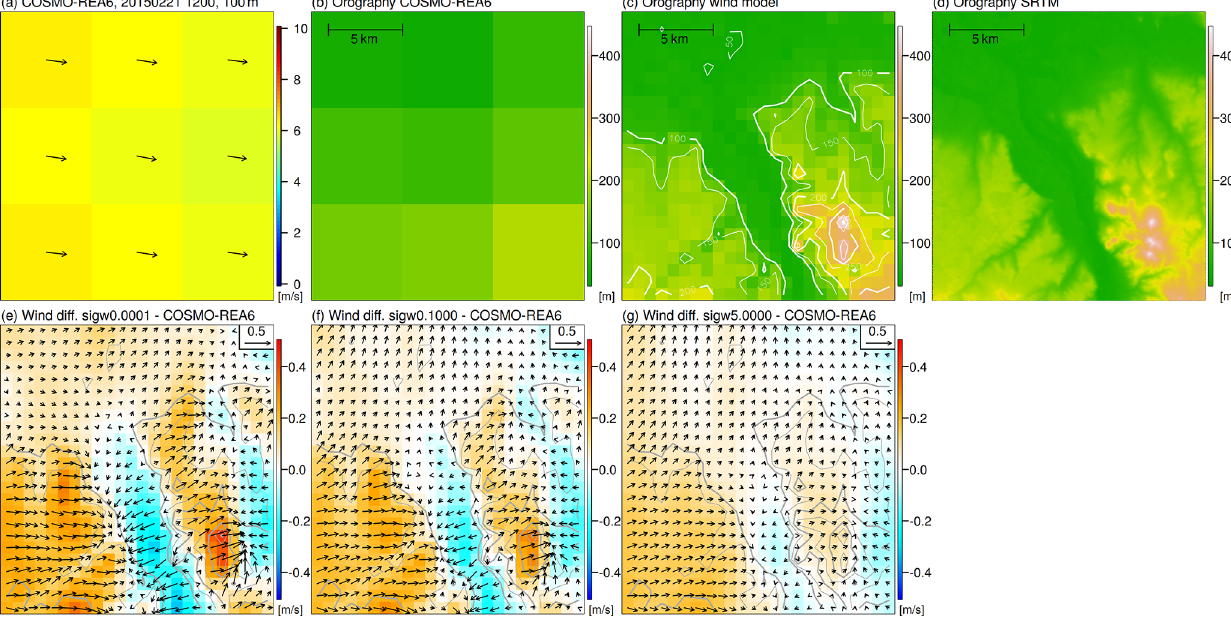
Figure 2. Snapshot of COSMO-REA6 wind speed (colors) and direction (arrows) on 21 February 2015 at 12:00UTC in western Germany (a) . Both wind components are vertically and horizontally interpolated from the native grid to 100m above surface and the grid box centers. Representation of the topography in COSMO-REA6 (b) , the diagnostic wind model (c) and in SRTM (d) . (e–g) Difference of the wind field from the diagnostic wind model with σ w values of 0 . 0001 (e) , 0 . 1000 (f) and 5 . 0000 (g) to COSMO-REA6. Red (blue) colors indicate higher (lower) wind speeds in the wind model compared to COSMO-REA6. Arrows show the differences between the wind components in the wind model and COSMO-REA6. The reference vector (top right) represents a difference of 0 . 5ms − 1 . The grey contour lines represent the topography in the diagnostic wind model.